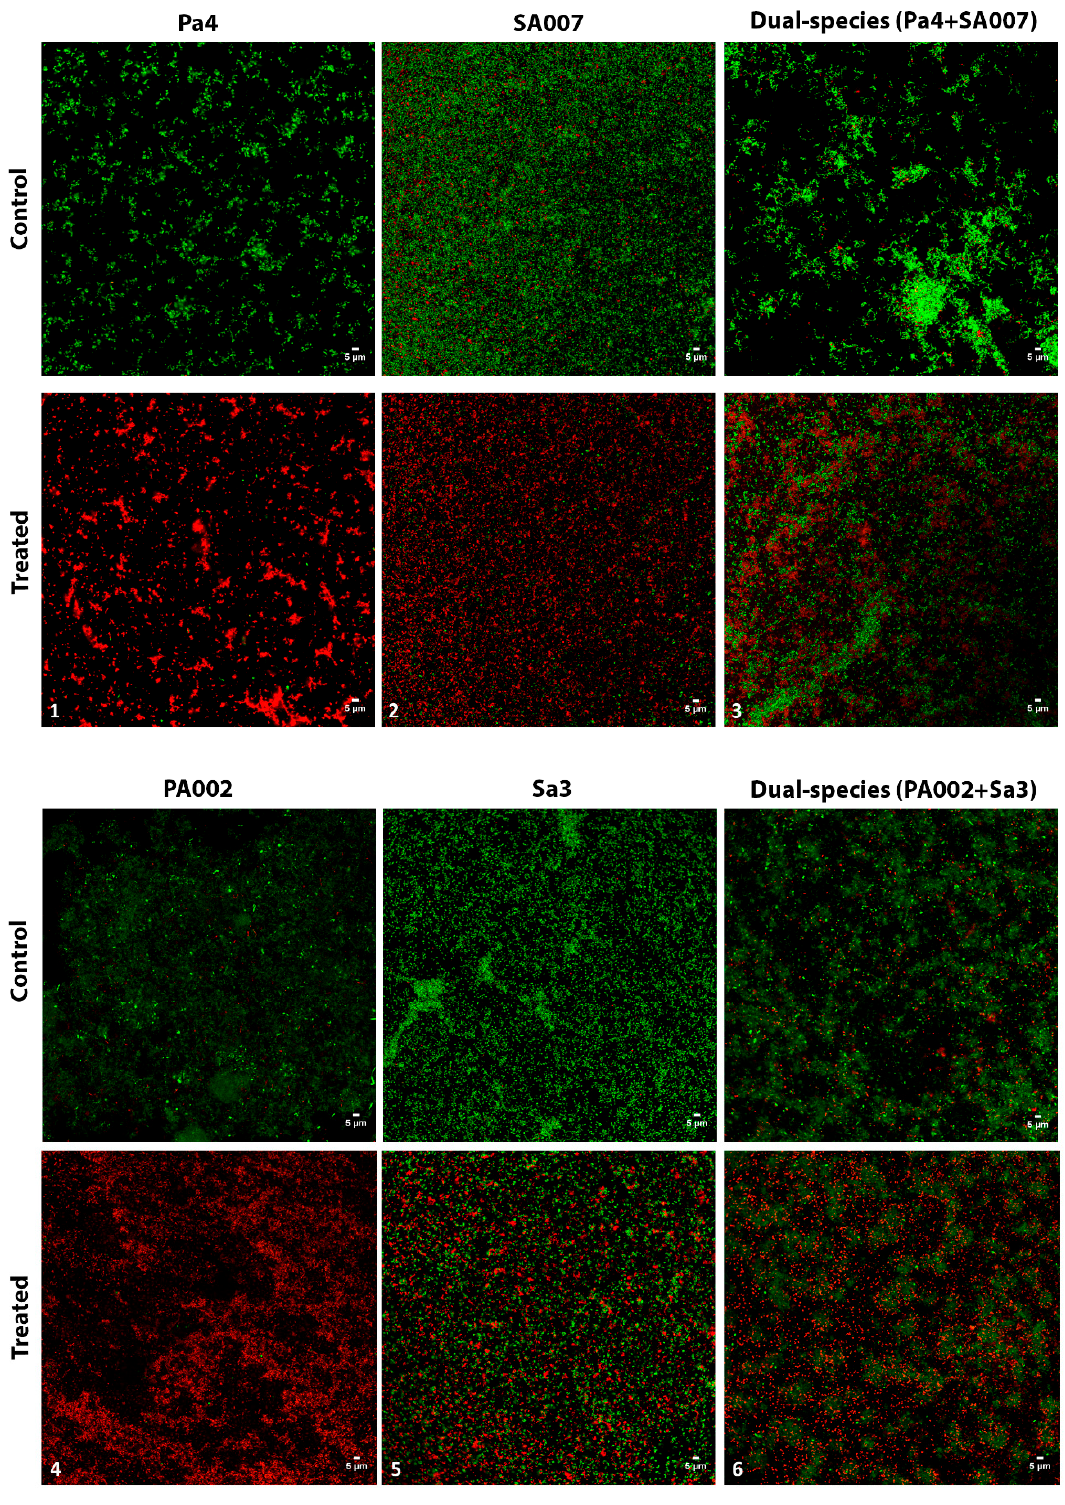
Figure 3. Confocal laser scanning microscopy (CLSM) images of single- and dual-species multidrug-resistant (MDR) P. aeruginosa and methicillin-resistant S. aureus (MRSA) biofilms. Biofilms were grown for 24 h and then treated for further 24 h with peptide Hs02 ( 1 – 6 ). Control images: no antimicrobial added. 1 , 2 , and 3 : 8× MIC peptide Hs02 (32 μ g/mL); 4 : 8× MIC (128 μ g/mL); 5 : 8× MIC (64 μ g/mL). 6 : 128 μ g/mL.